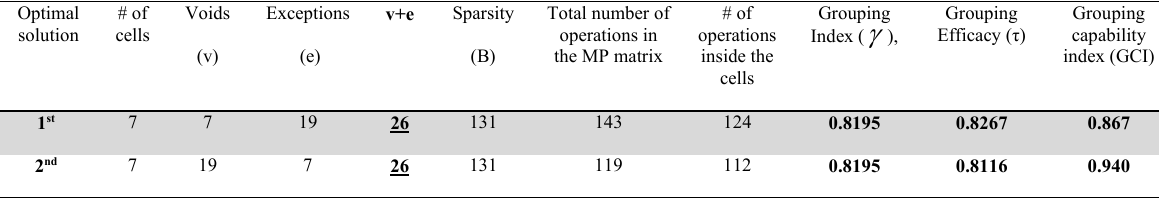
Evaluation of different measures Optimal